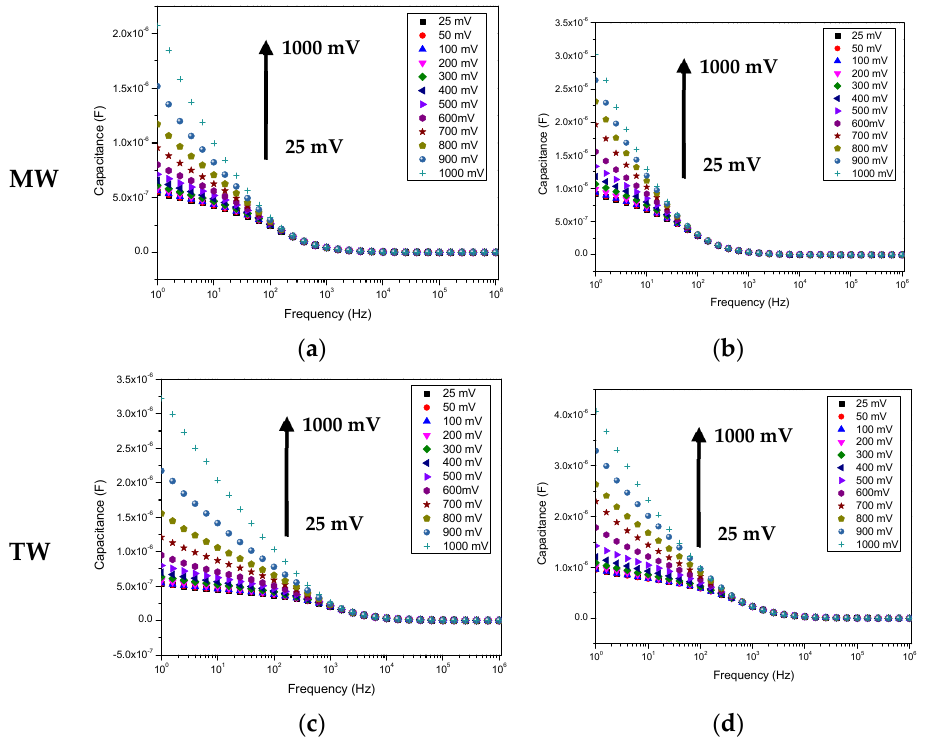
Figure 3. Capacitance spectra of the sensor devices, when immersed in water solutions with a concentration of 10 − 12 M of EE2, for a range of applied voltages: ( a ) uncoated IDE in MW, ( b ) IDE coated with (PEI/PSS) 5 film in MW, ( c ) uncoated IDE in TW, ( d ) IDE coated with (PEI/PSS) 5 in TW. The relative error is less than 1%. Arrow indicates the evolution of voltage values, from 25 mV up to 1000 mV.